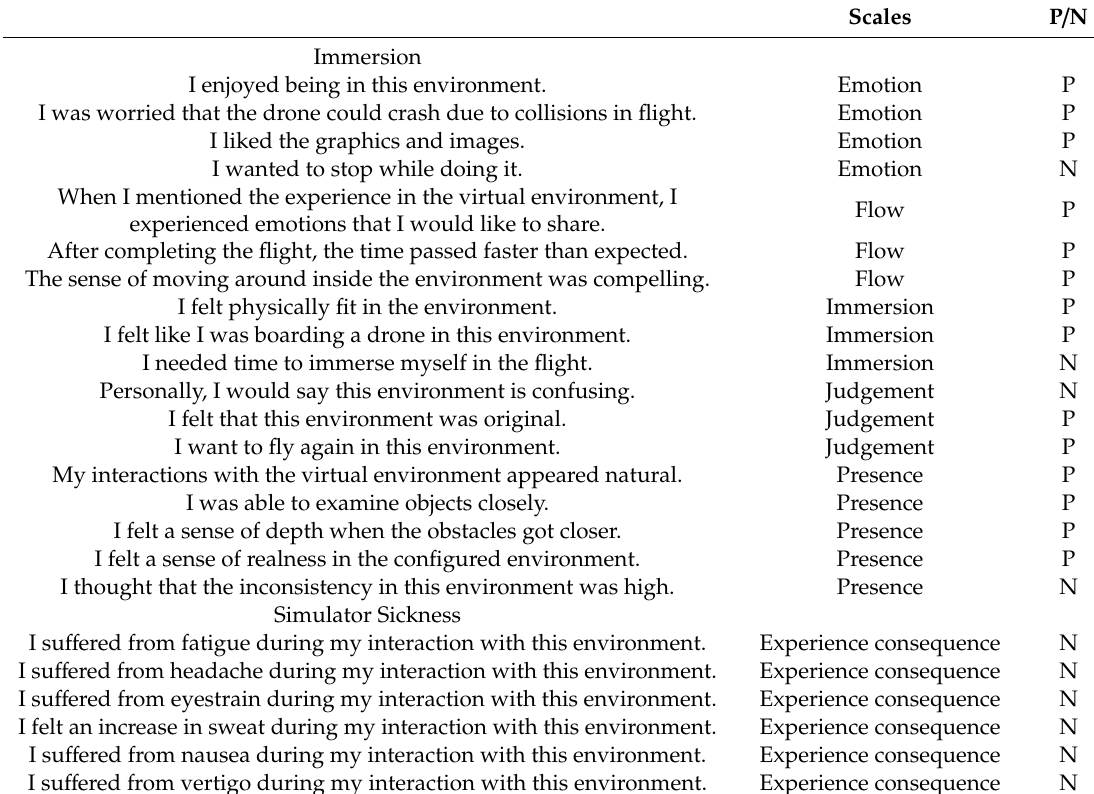
Table 1. The questionnaire for immersion and simulator